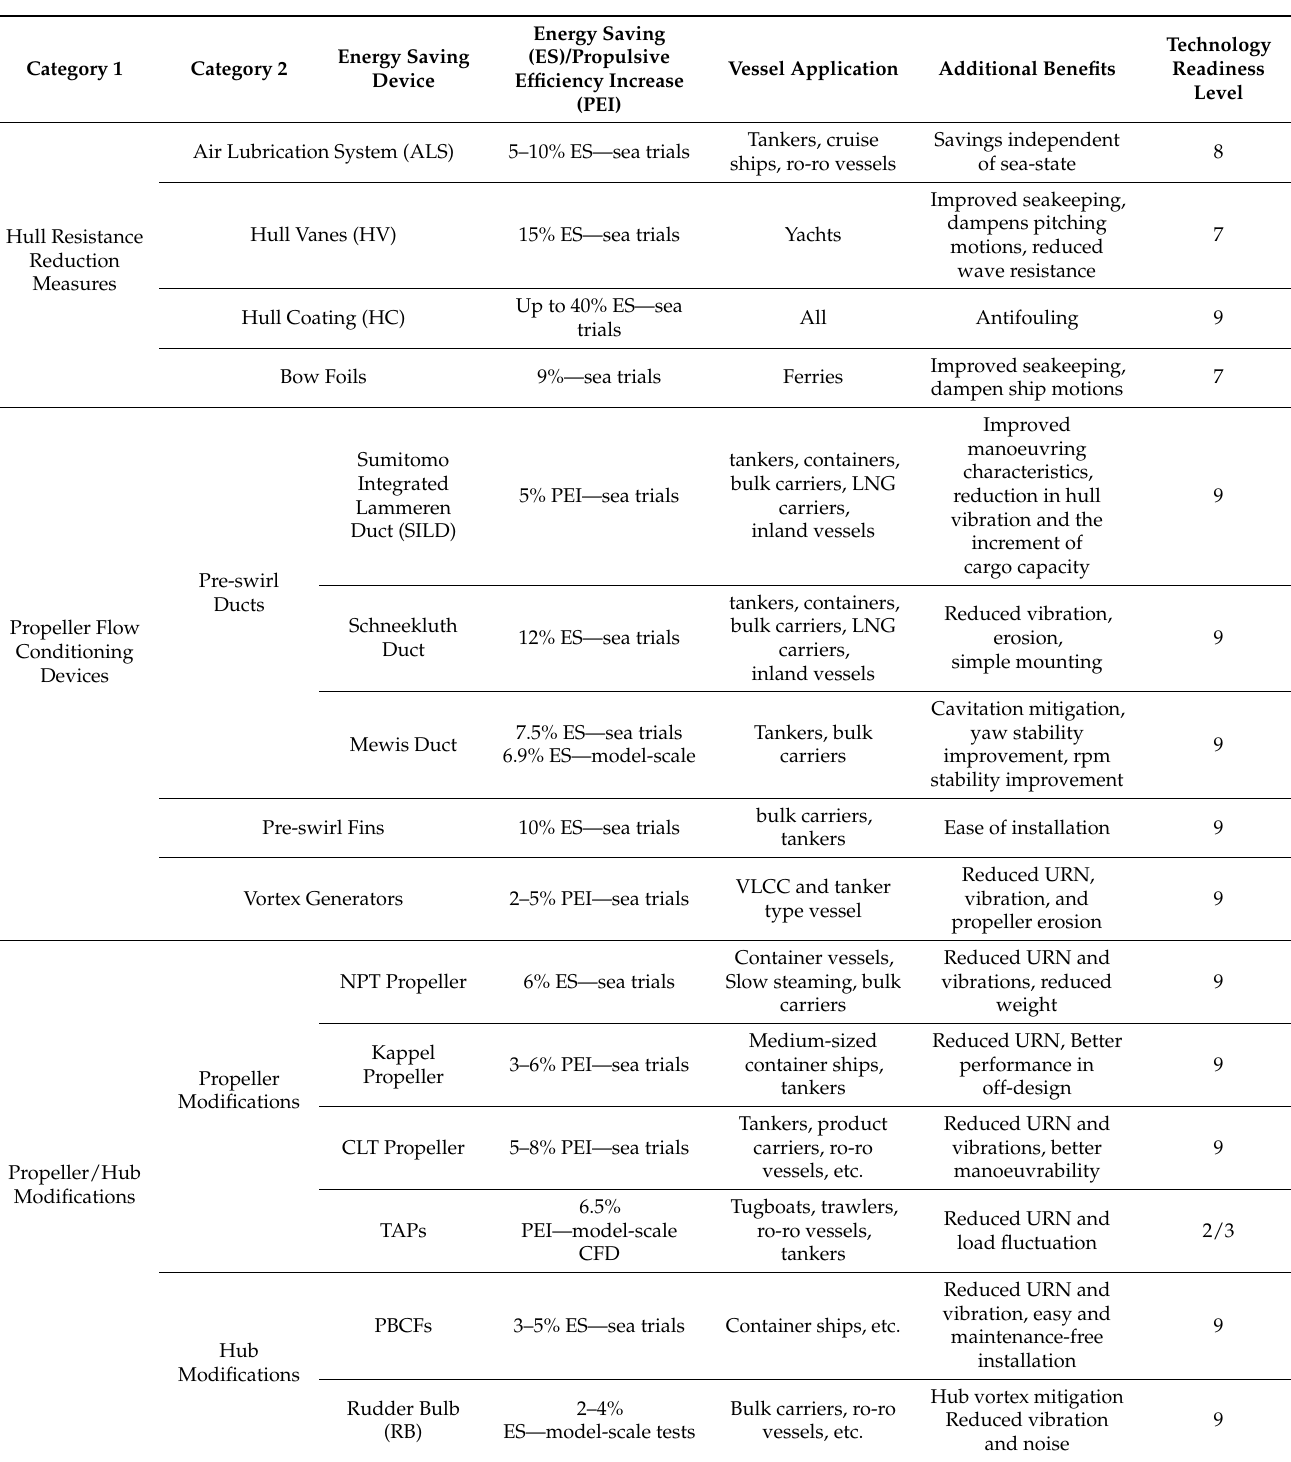
Table 3. Summary of ESDs and their energy saving capability and other key